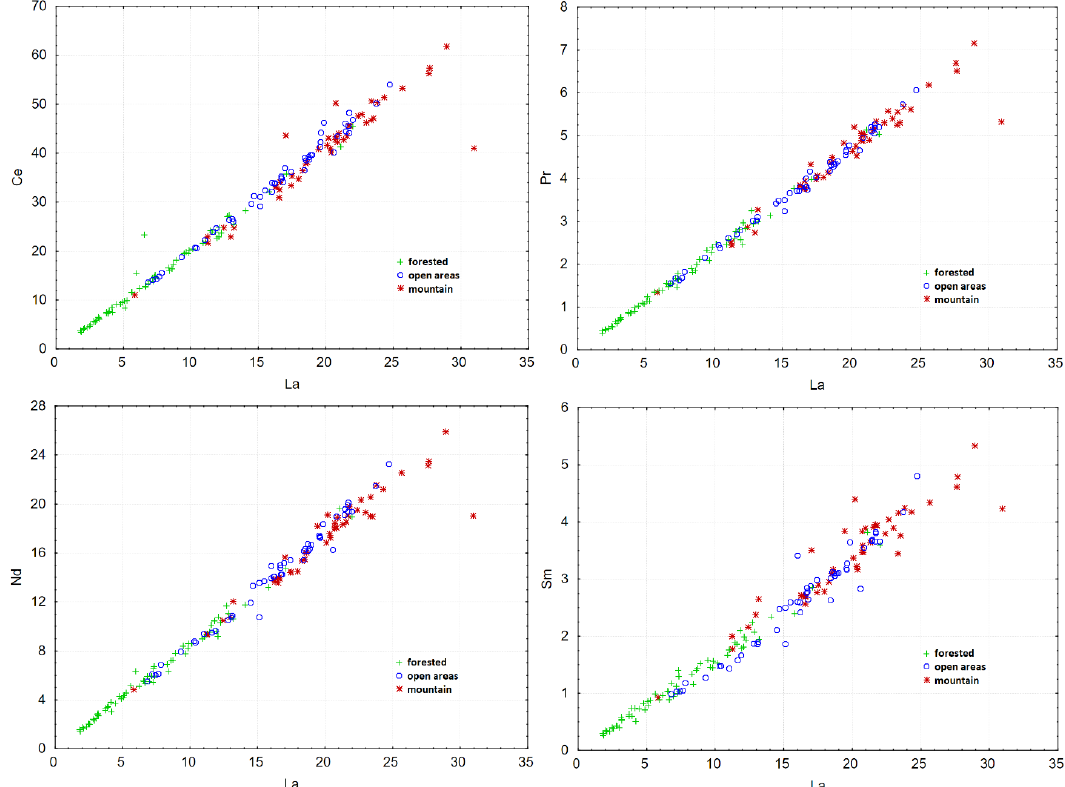
Figure 3. Scatterplots of ratios La to: Ce, Pr, Nd and Sm concentrations for forested, open, and mountain areas; the points on the scatterplots were marked depending on the area, where the measurements was taken: forested areas by crosses (USIA forest 1, 2, and 3), open areas by circles (USIA open 1 and 2), and mountain areas by stars (Izera open and Izera forest).